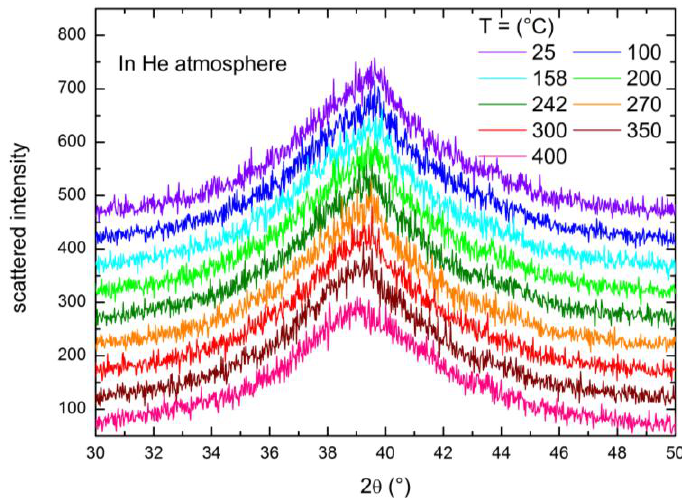
Figure 6. X-ray diffractograms measured with increasing temperature with the sample kept in a He atmosphere (p ~ 1 bar).